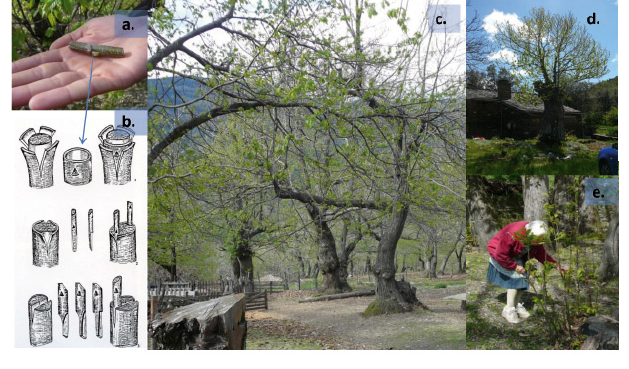
Fig. 3 . Grafting and renovation processes of chestnut